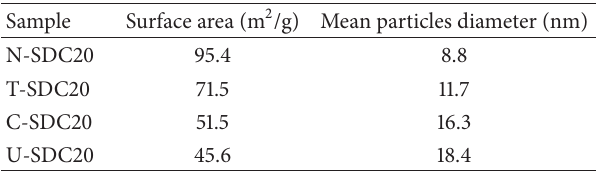
Table 2: Surface area (m 2 /g) and mean particles diameter of the calcined